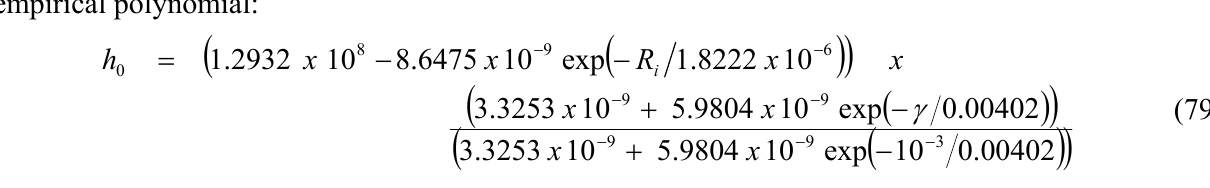
Figure 11. The curves correspond to the interaction potential between two deformable = 3.9 μ m, A = 5.03 x 10 -21 J, C = 10 -4 M, γ = drops of dodecane suspended in water ( R i H s = 1.6 x 10 -12 N). (a) Sum of Extensional, Bending and van der Waals 48.5 mN/m, B 0 potentials. (b) Sum of Electrostatic and van der Waals